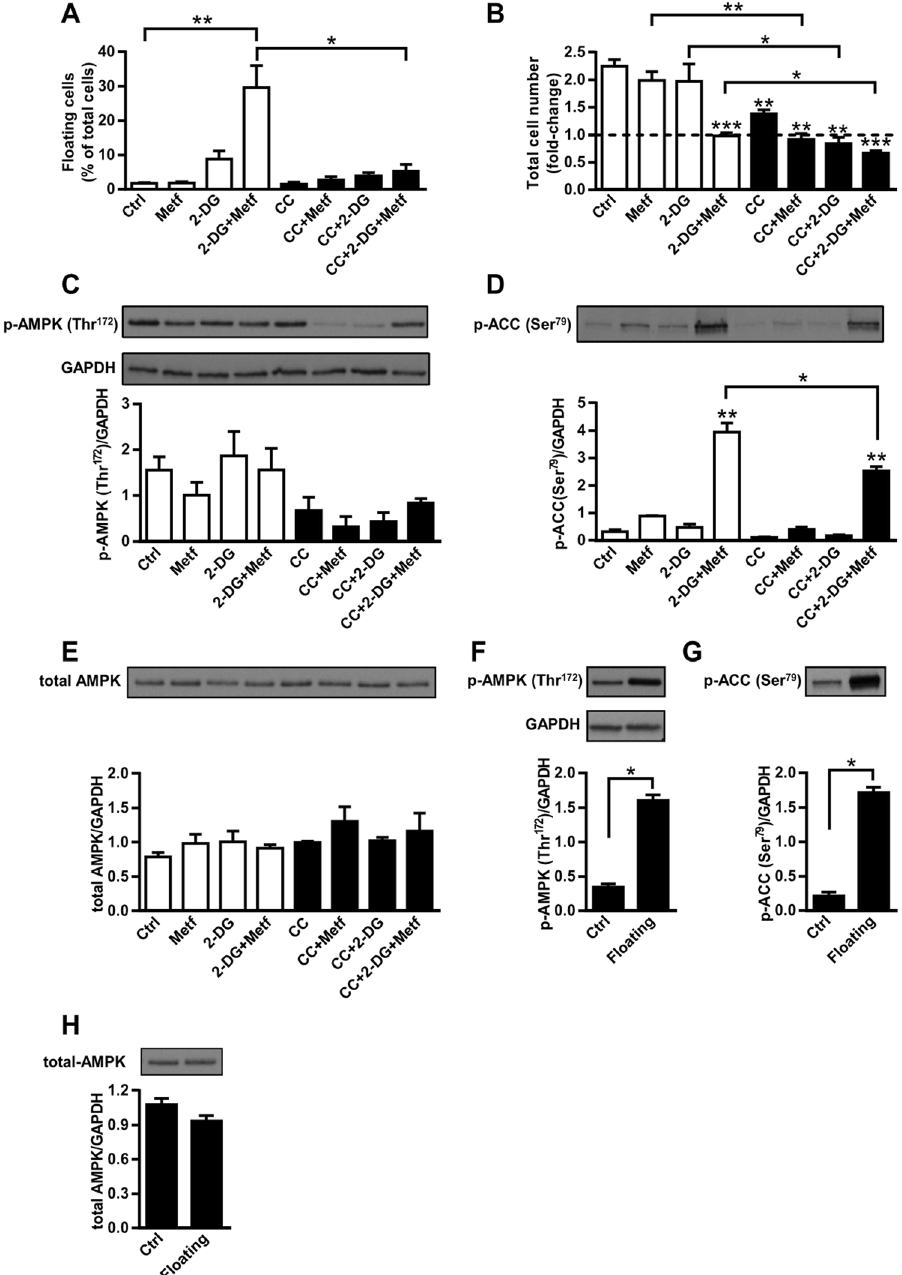
Figure 5. AMPK activation is needed for detachment of viable MDA-MB-231 cells. ( A , B ) MDA-MB-231 cells were pre-treated for 2 h with 5 µ M Compound C in medium with glucose. Then 5 mM metformin and/ or 600 µ M 2-DG were added. After two days, the fraction of floating cells in each sample ( A ) and total number of cells normalized to the number of seeded cells ( B ) were determined. Results are means ± SEM (n = 3). ( A ) * P ≤ 0 . 001 ; ** P < 0 . 0001 . (B ) * P ≤ 0 . 05 ; ** P ≤ 0 . 01; *** P < 0 . 001 . ( C–E ) MDA-MB-231 cells were pre- treated with 5 µ M Compound C in medium with glucose. Then 5 mM metformin and 600 µ M 2-DG were added for additional 24 h. Phosphorylation of AMPK ( C ) and ACC ( D ) and total AMPK level (E ) were determined by Western blot analysis. Cropped blots are shown. Uncropped blots are presented in Supplementary Fig. S9. Results are means ± SEM (n = 3). * P ≤ 0 . 05 ; ** P < 0 . 0001 . ( F , G , H ) MDA-MB-231 cells were grown in a regular cell culture plate or in a cell culture plate covered with poly-HEMA (to prevent cell adhesion) for three days. Phosphorylation of AMPK ( F ), ACC ( G ) and total AMPK level ( H ) were determined by Western blot analysis. Cropped blots are shown. Uncropped blots are presented in Supplementary Fig. S9. Results are means ± SEM (n = 3). * P < 0 . 0001